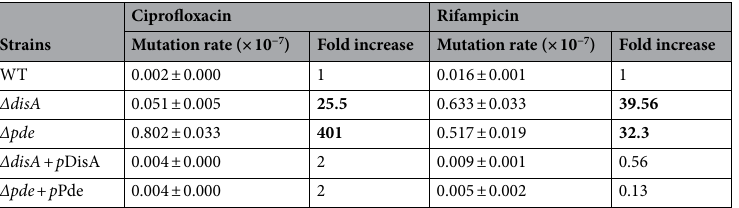
Table 1. Specific fold changes in spontaneous mutation rates for different strains against ciprofloxacin and rifampicin. Significant values are in [bold].